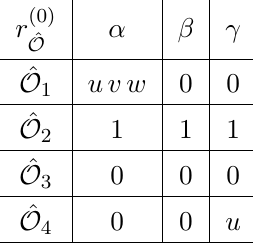
= F (0) = F (0) ^ O ^ O ^ O 2 I I